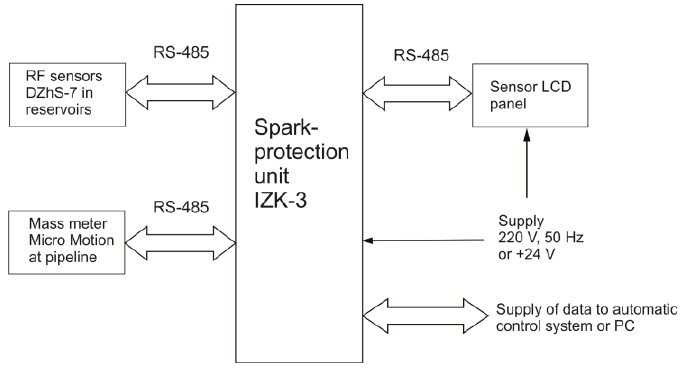
Fig. 1. Structural scheme of the measuring